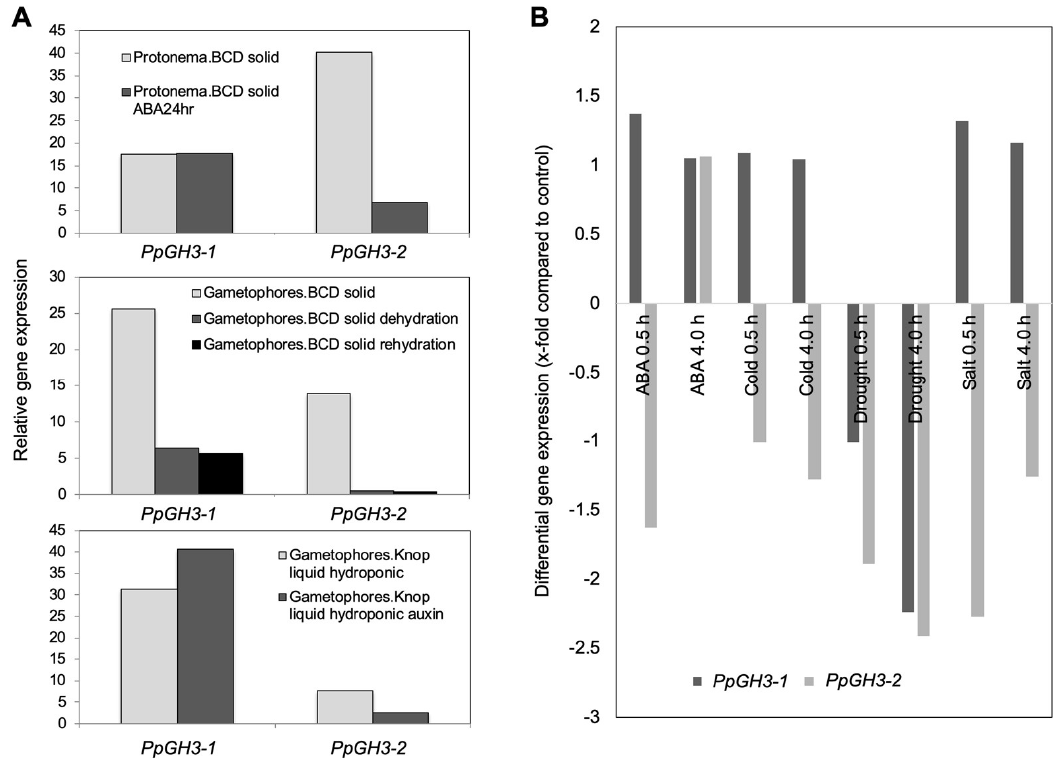
Figure 3. Selected samples from digital gene expression analysis of both GH3 genes using published data from Gene Atlas (Phytozome) [41,42] ( A ) and eFP browser [43,44] ( B ).